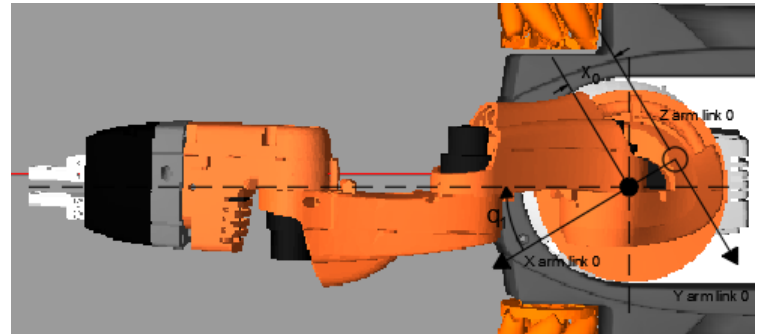
Figure 3. Cartesian coordinate system of the Kuka TM youBot